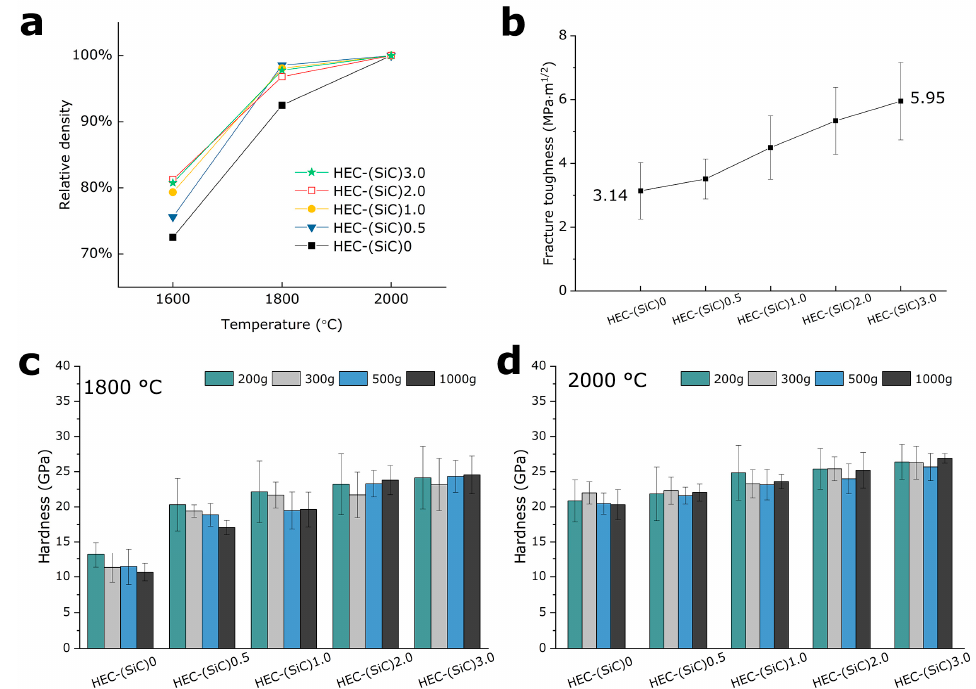
Figure 1. ( a ) The relative densities of high-entropy ceramic (HEC)-(SiC)x (x = 0, 0.5, 1.0, 2.0, 3.0) composites at different sintering temperatures, ( b ) fracture toughness of the composite from 2000 °C, ( c ) and ( d ) are the Vickers hardness of HEC-(SiC)x composite at 1800 °C and 2000 °C, respectively, as function of different indentation